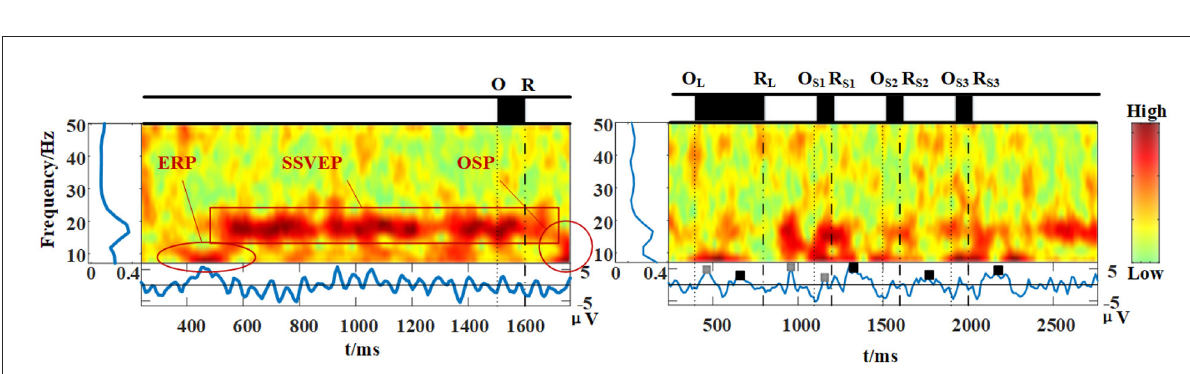
Xu et al., 2013, 2014; Wu et al., 2016). This result extends the application range of OSP, without the limitation of the monitor’s refresh rate in the periodic flickering stimuli.